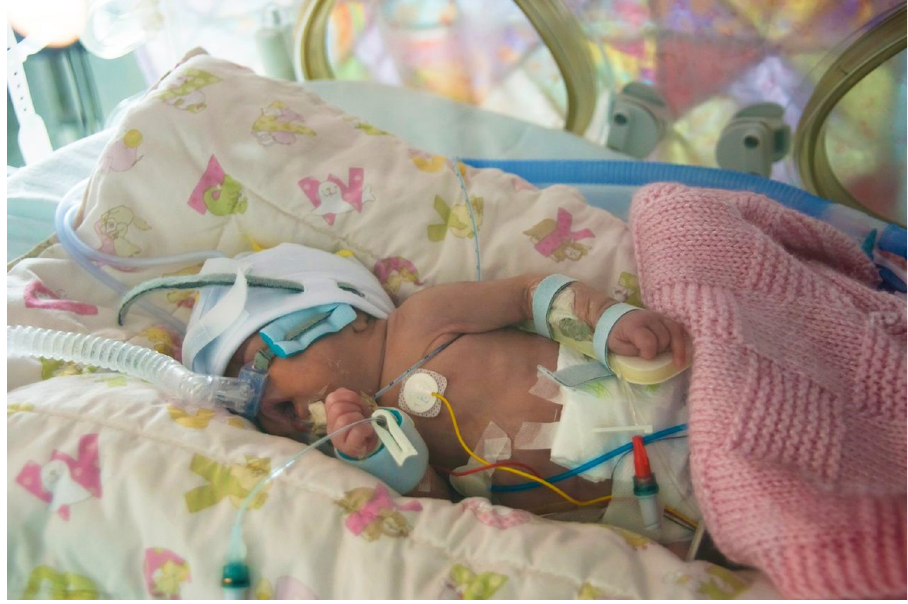
Fig 1. Preterm infant lying inside an incubator at a neonatal intensive care unit (NICU). The limited space inside the incubator and the “spaghetti of wires, lines and tubes” makes it difficult to measure the body size without causing stress to the infant. (image: CC BY BMJ Bonner et al.